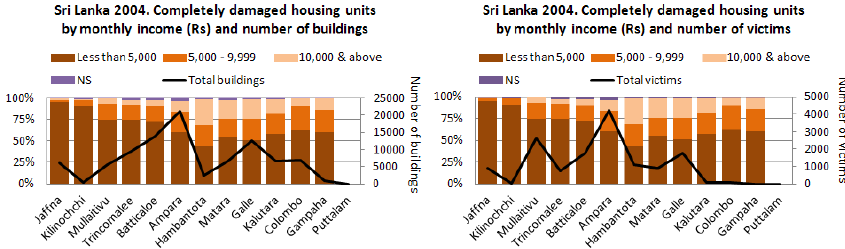
Figure 14. Percentage distribution of completely damaged housing units (left) and number of tsunami victims (right) by reported monthly